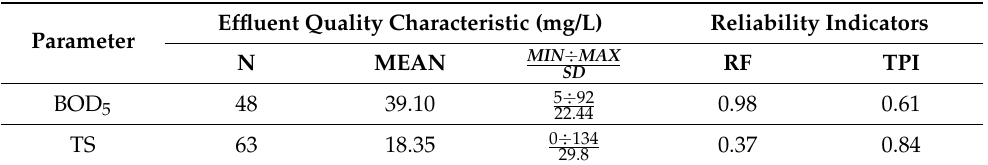
Table 5. Effluent quality characteristic, reliability factor (RF), and technological purity index (TPI) calculated for tested on-site wastewater treatment